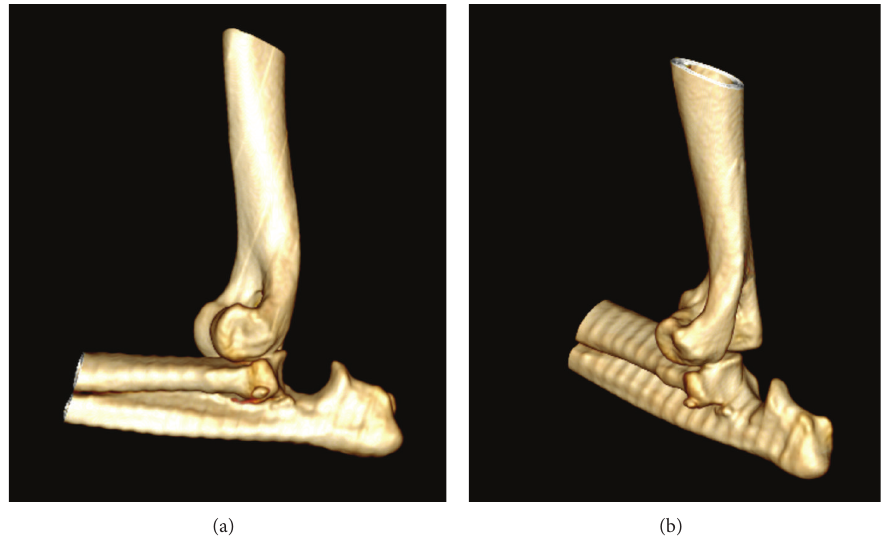
Figure 1: (a) CT 3D reconstruction of left elbow viewed from lateral aspect demonstrating caudal luxation of the humeroradial and humeroulnarjoint.(b)CT3Dreconstructionofleftelbowviewedfromcaudolateralaspectdemonstratingcaudalluxationofthehumeroradial and humeroulnar joint.